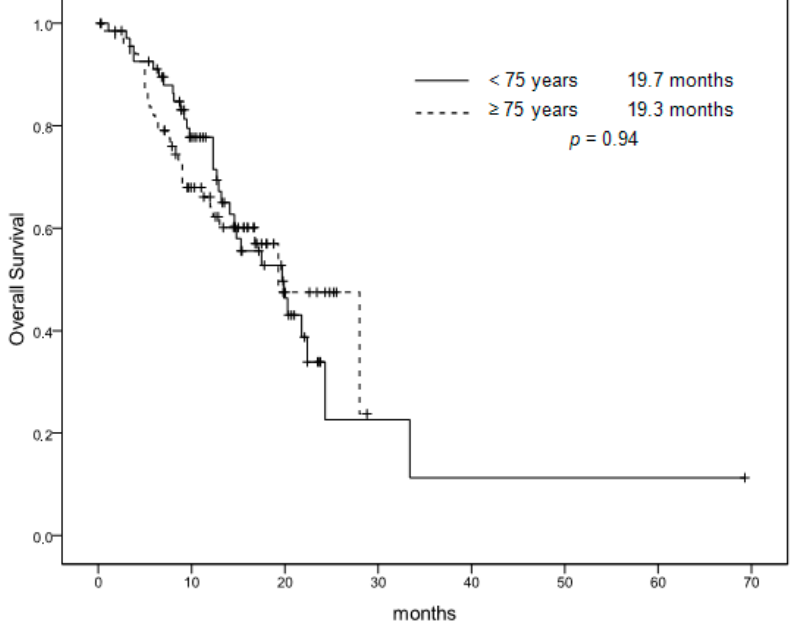
Figure 2. Overall survival. Patients <75 years versus patients ≥ 75 years.